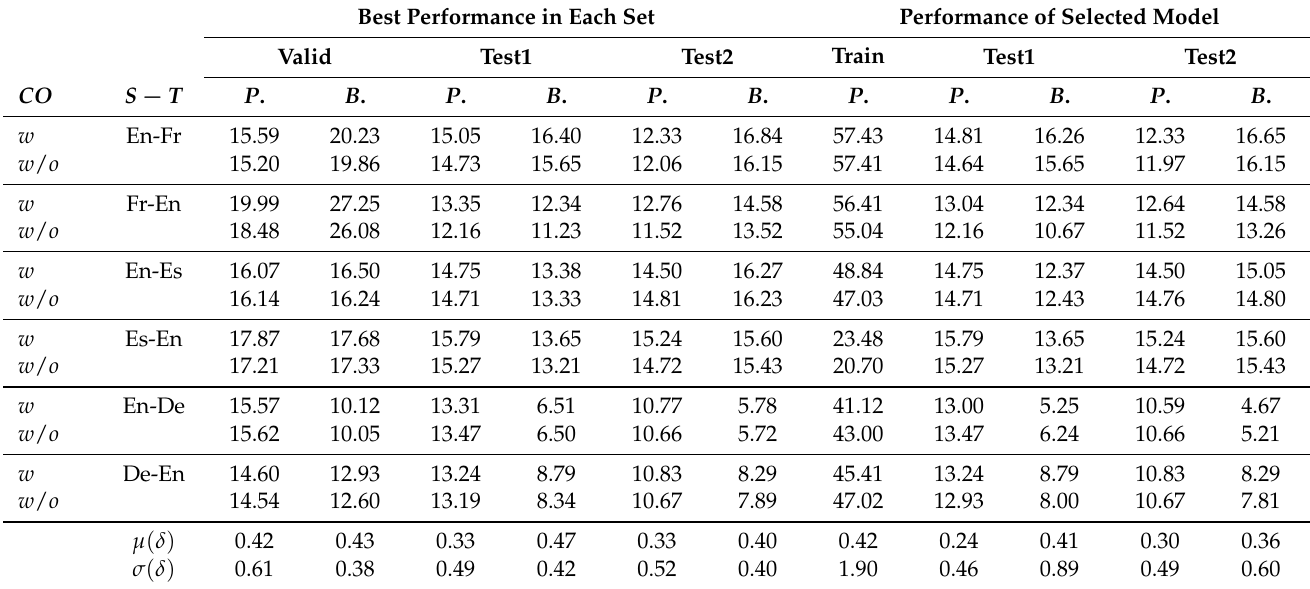
Table 7. Performance change by using Cost-Out in MT-hsoftmax. ( CO : Cost-Out, S − T : source-target, P .: precision, B .: BLEU, w and w / o : with and without Cost-Out, δ : performance gain when using Cost-Out (score of w − score of w / o ), µ ( δ ) : mean of δ , σ ( δ ) : standard deviation of δ ).